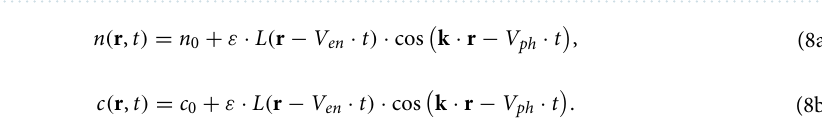
Figure 4. Propagation of bacterial waves at different times. The top panels depict approximate solutions calculated by injecting the hyperbolic secant distribution, and the bottom panels represent solutions derived using a Gaussian profile. k x = k y = 0.05, τ x = τ y = 10 2 , D 2 = 1.62 . Left panels t = 5 · 10 − 3 , middle t = 0.5 and right panels t = 1 . Other parameters as in Fig.